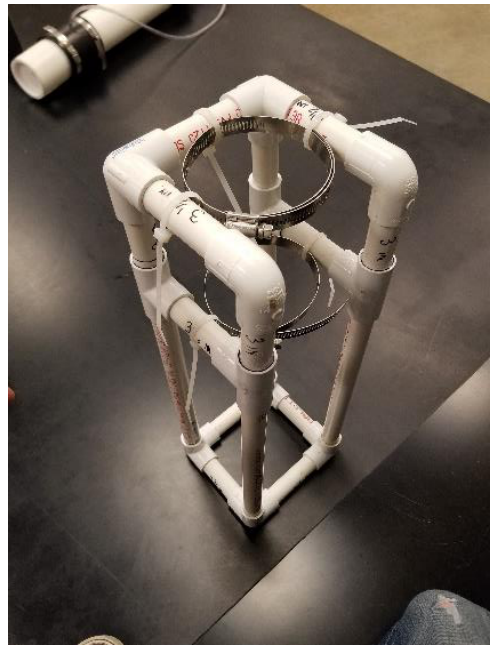
Figure 5. The constructed soil column stand.